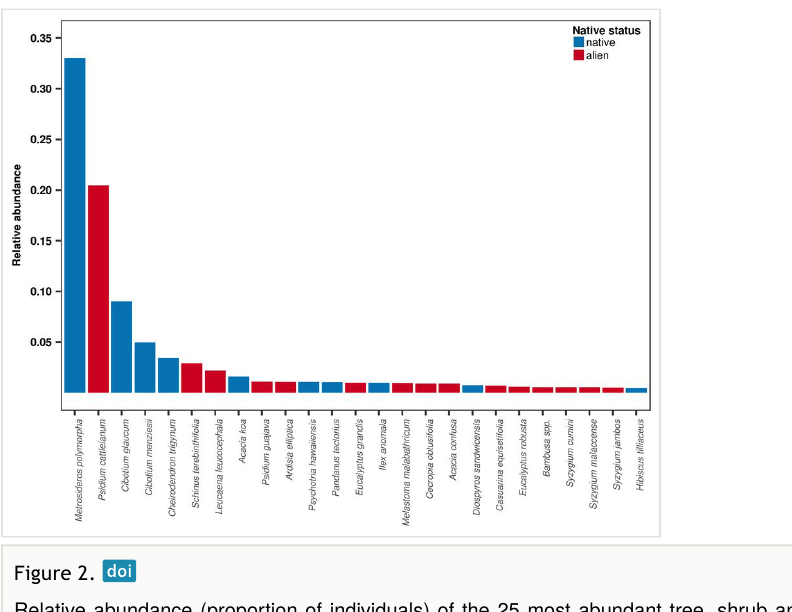
Relative abundance (proportion of individuals) of the 25 most abundant tree, shrub and tree fern species across the Hawaiian archipelago in the OpenNahele database.